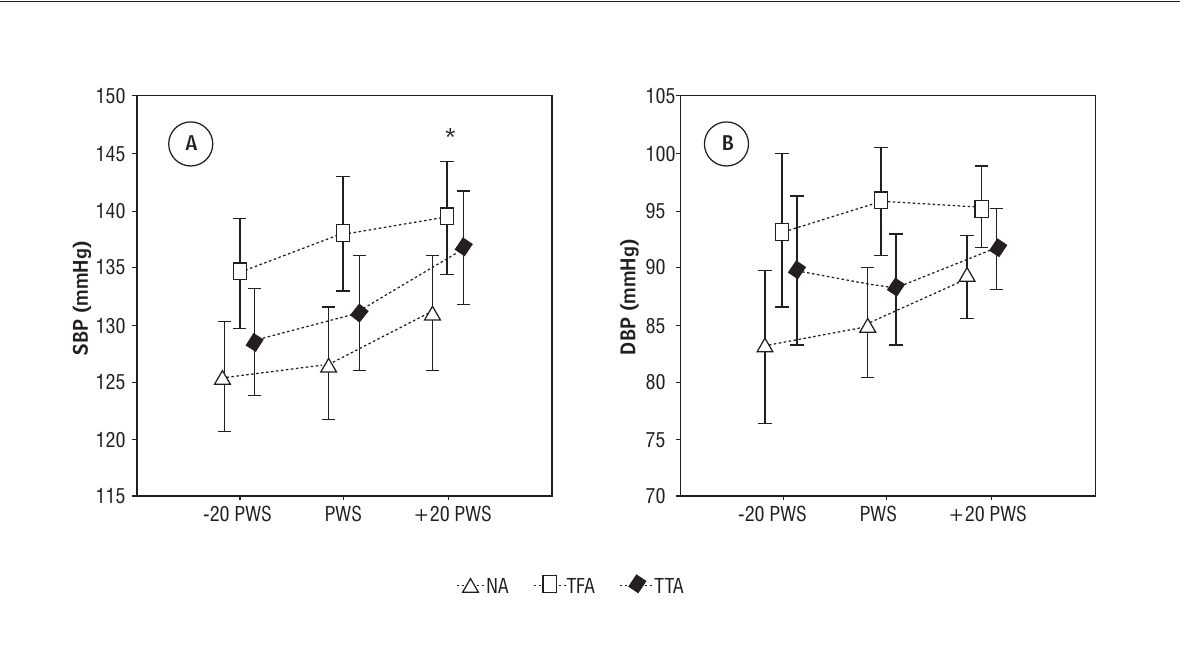
Figure 1 - Intragroup comparison with regards to systolic blood pressure (SBP) and diastolic blood pressure (DBP), respec- tively. Graphics A and B, with the increase of gait speed (-20 PWS; PWS and +20 PWS), reached by the Non Amputee (NA), Transtibial Amputee (TTA) and Transfemoral Amputee (TFA) groups. Data are presented as mean and with a 95 % confidence